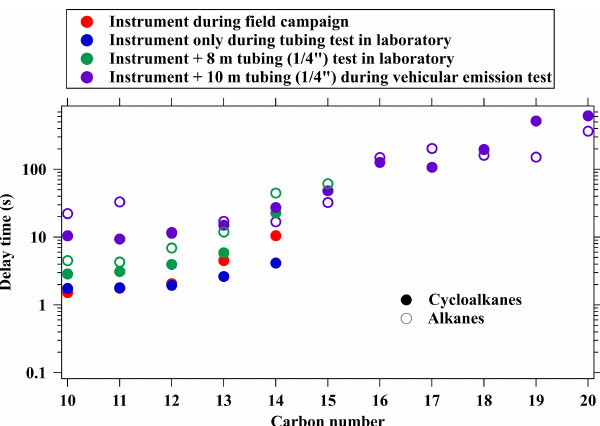
Figure 5. Delay time of cycloalkanes determined from measure- ments in the field, laboratory experiments, and vehicular emissions. The delay times of alkanes from Wang et al. (2020) are also shown for